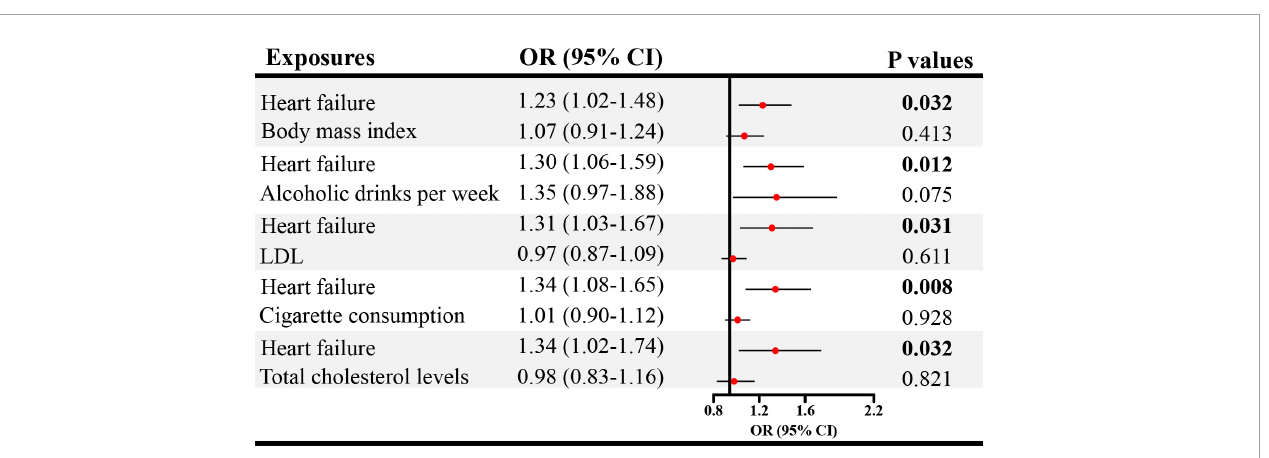
FIGURE5 The direct causal effects of heart failure on ED in MVMR. MVMR, multivariable Mendelian randomization; OR, odds ratio; CI, confidence